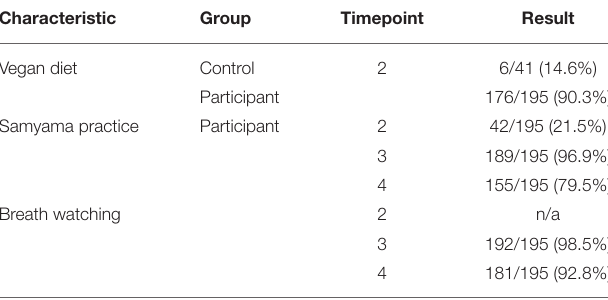
TABLE 3 | Diet and meditation